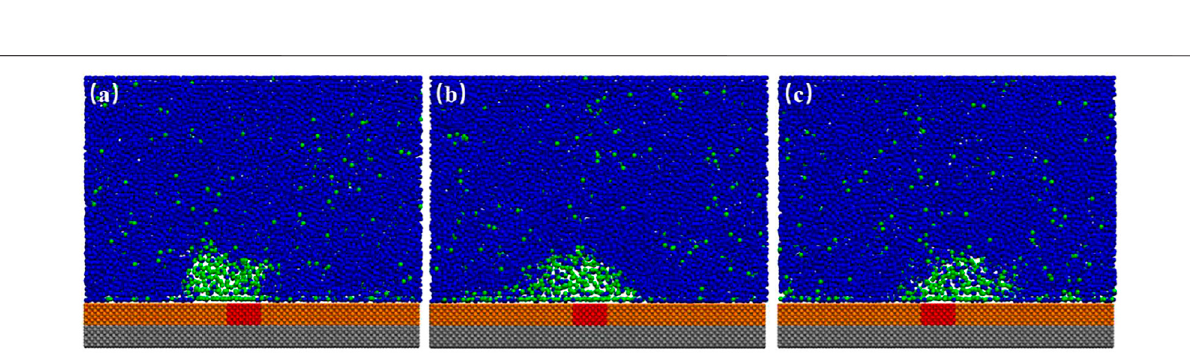
Frontiers in Materials |